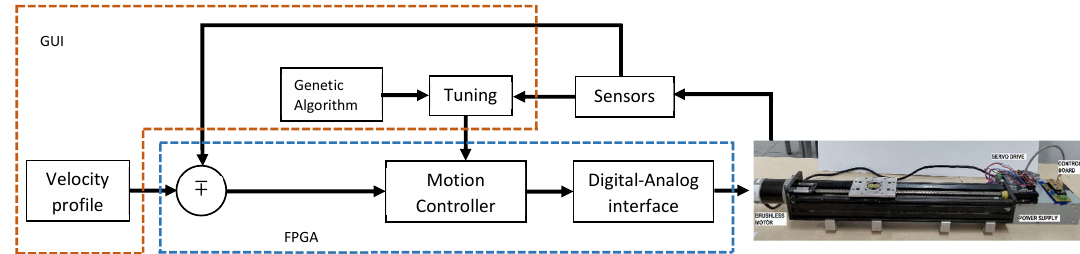
Figure 8. Methodology for control and